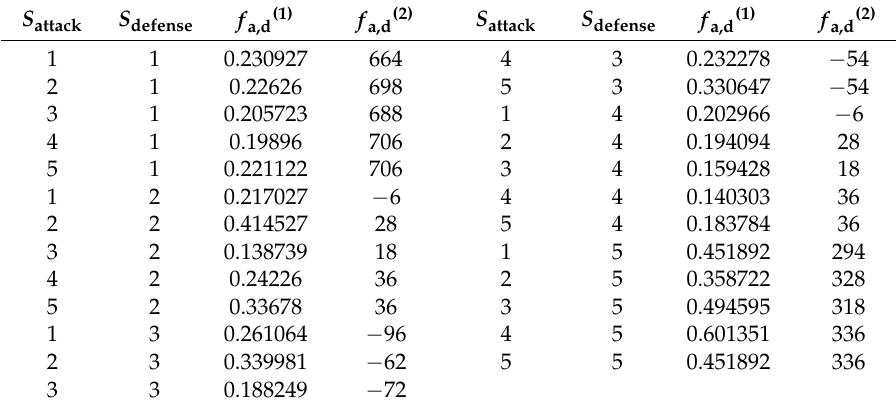
Table 3. Goal function results.